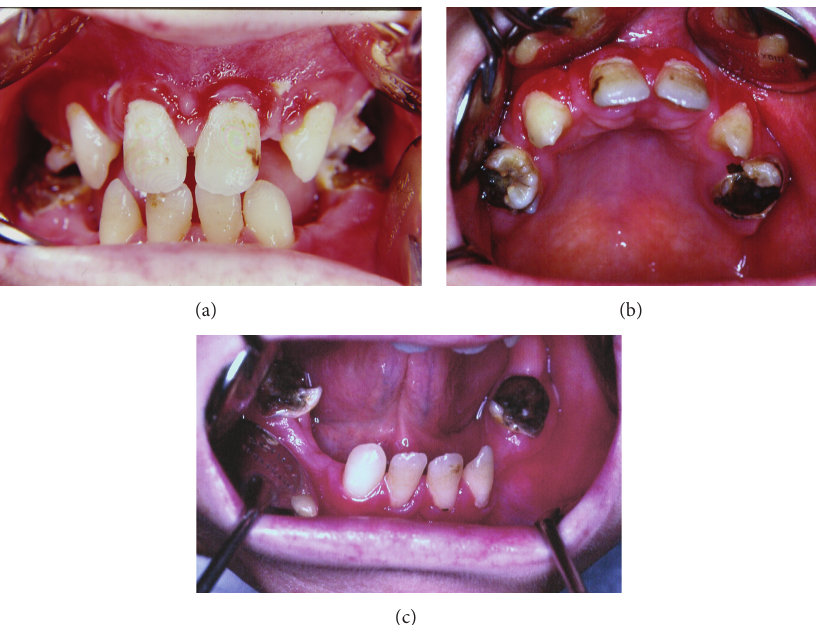
Figure 3: (a) The appearance of the edematous gingival and hyperplasic papillae. (b) The appearance of the maxilla reveals that only right and left first molars, canine, and central incisor teeth are present. Also widespread caries are seen on first molars. (c) The appearance of the mandible reveals that only right and left first molars, lateral incisor, and central incisor teeth are present. Also widespread caries are seen on first